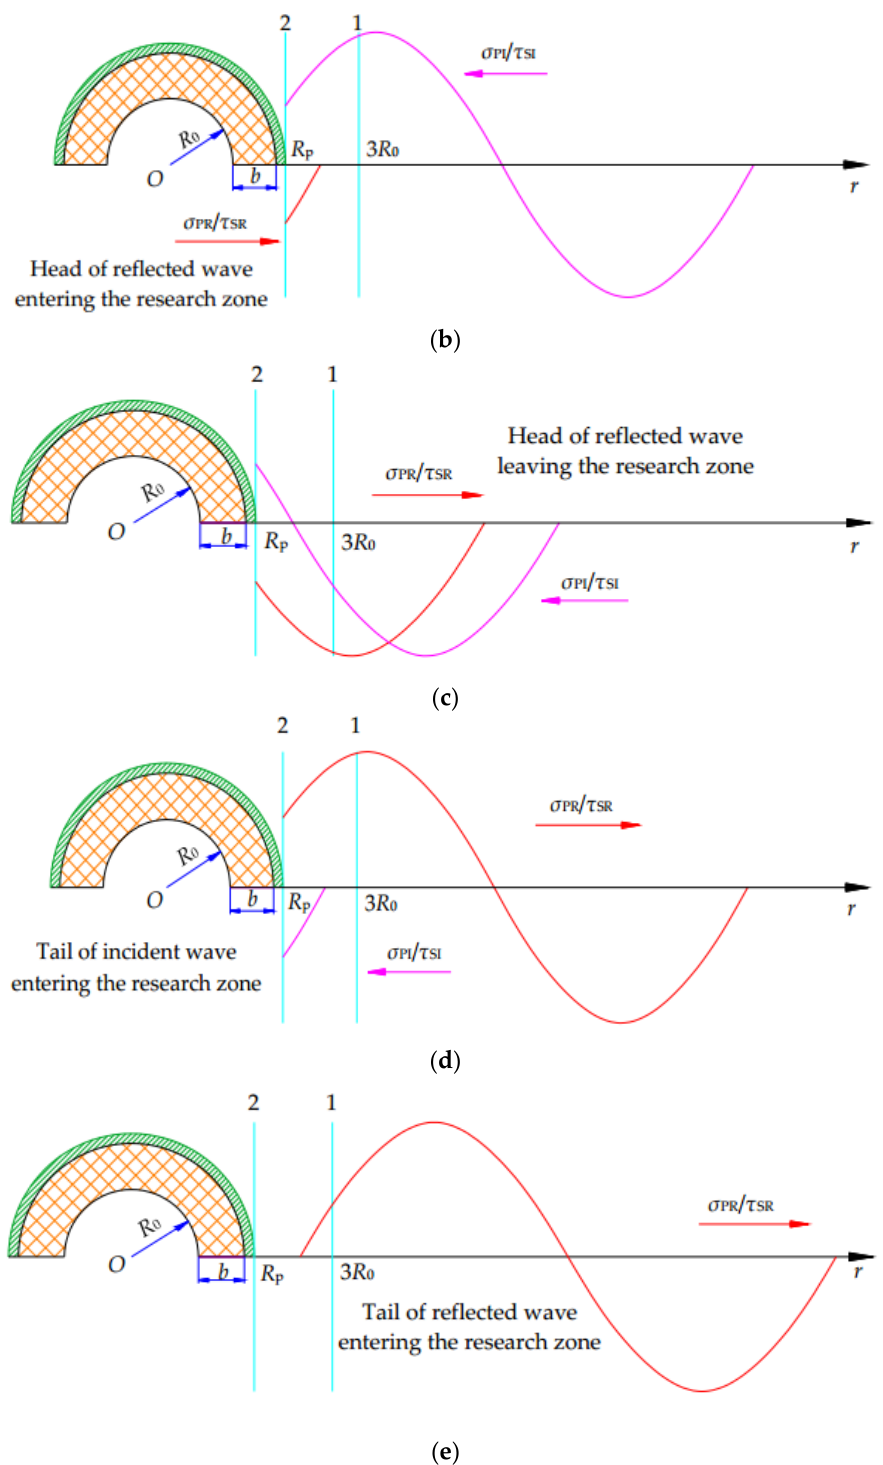
Figure 3. Five time periods divided based on action processes of stress waves, including: ( a ) first time period: head of incident wave entering the research zone; ( b ) second time period: head of reflected wave entering the research zone; ( c ) third time period: head of reflected wave leaving the research zone; ( d ) fourth time period: tail of incident wave entering the research zone; ( e ) fifth time period: tail of reflected wave entering the research zone.